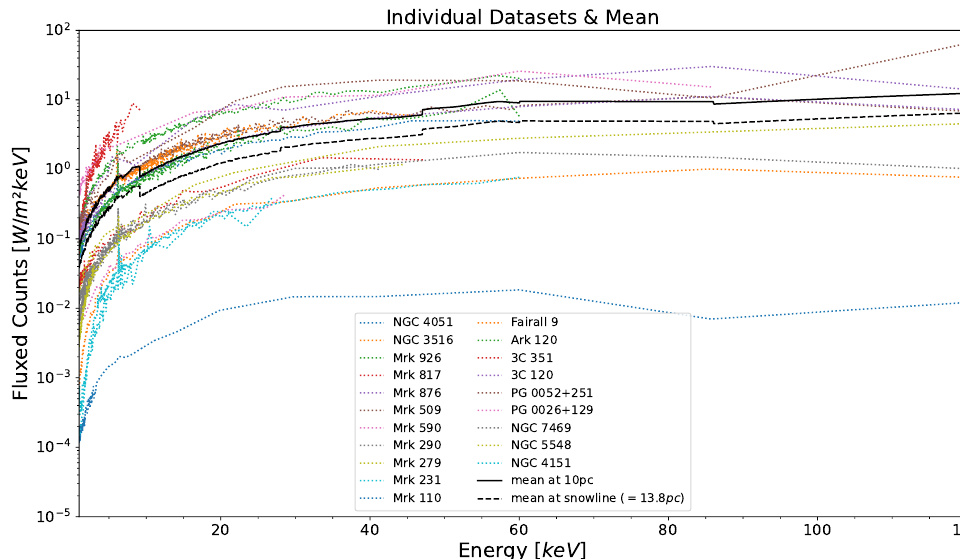
Figure 2. Data of individual X-ray spectra based on a catalog of AGNs [8] (between 1 and 120 keV) of 20 Seyfert 1 AGNs used in this work (colored and dotted) as they would be observed at a distance of 10 pc, as well as the mean of their spectra as it would be observed a distance of 10 pc (black, solid line) and at a snowline distance of 13.8 pc (black, dashed line), with the snowline distance determined cutting off at 1.24 eV instead of 1 keV. (CC BY